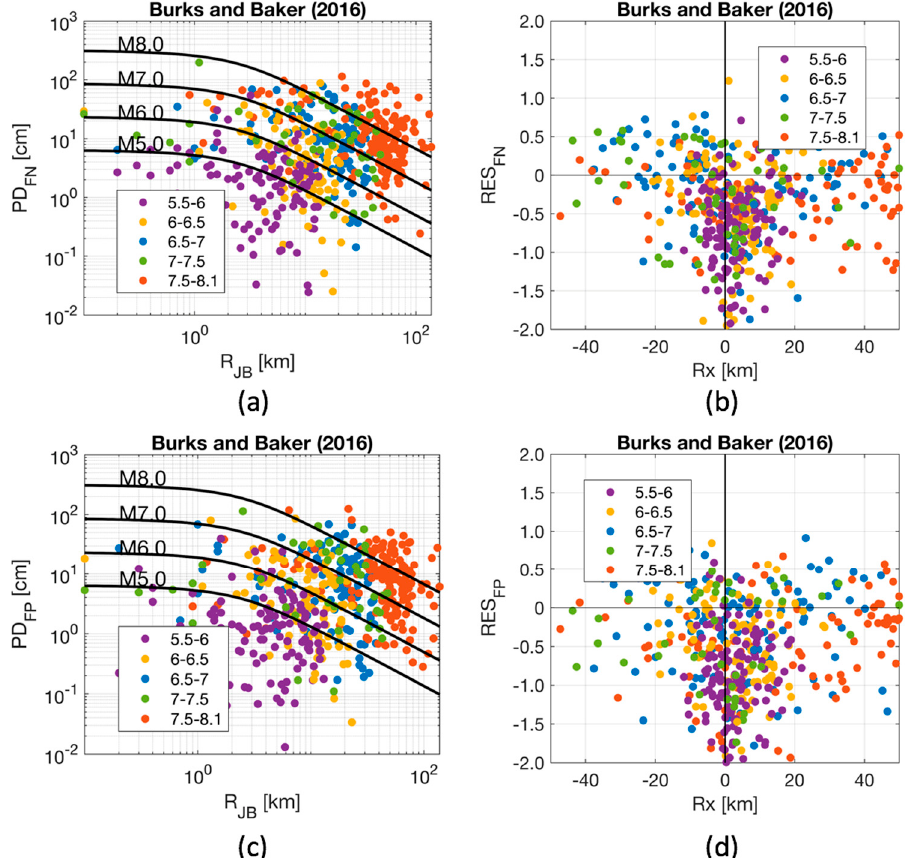
Figure 8. ( a , c ) Horizontal permanent displacement (PD, FN and FP components, respectively) amplitude versus the Burks and Baker (2016) [23] model (solid lines) expressed in terms of RJB distance for the magnitude range 5.0–8.0; ( b , d ) residuals computed as the log difference between the horizontal (FN and FP) permanent displacement computed through eBASCO and the Burks and Baker (2016) [23] predicted values. Dots are color-coded based on the magnitude bin.